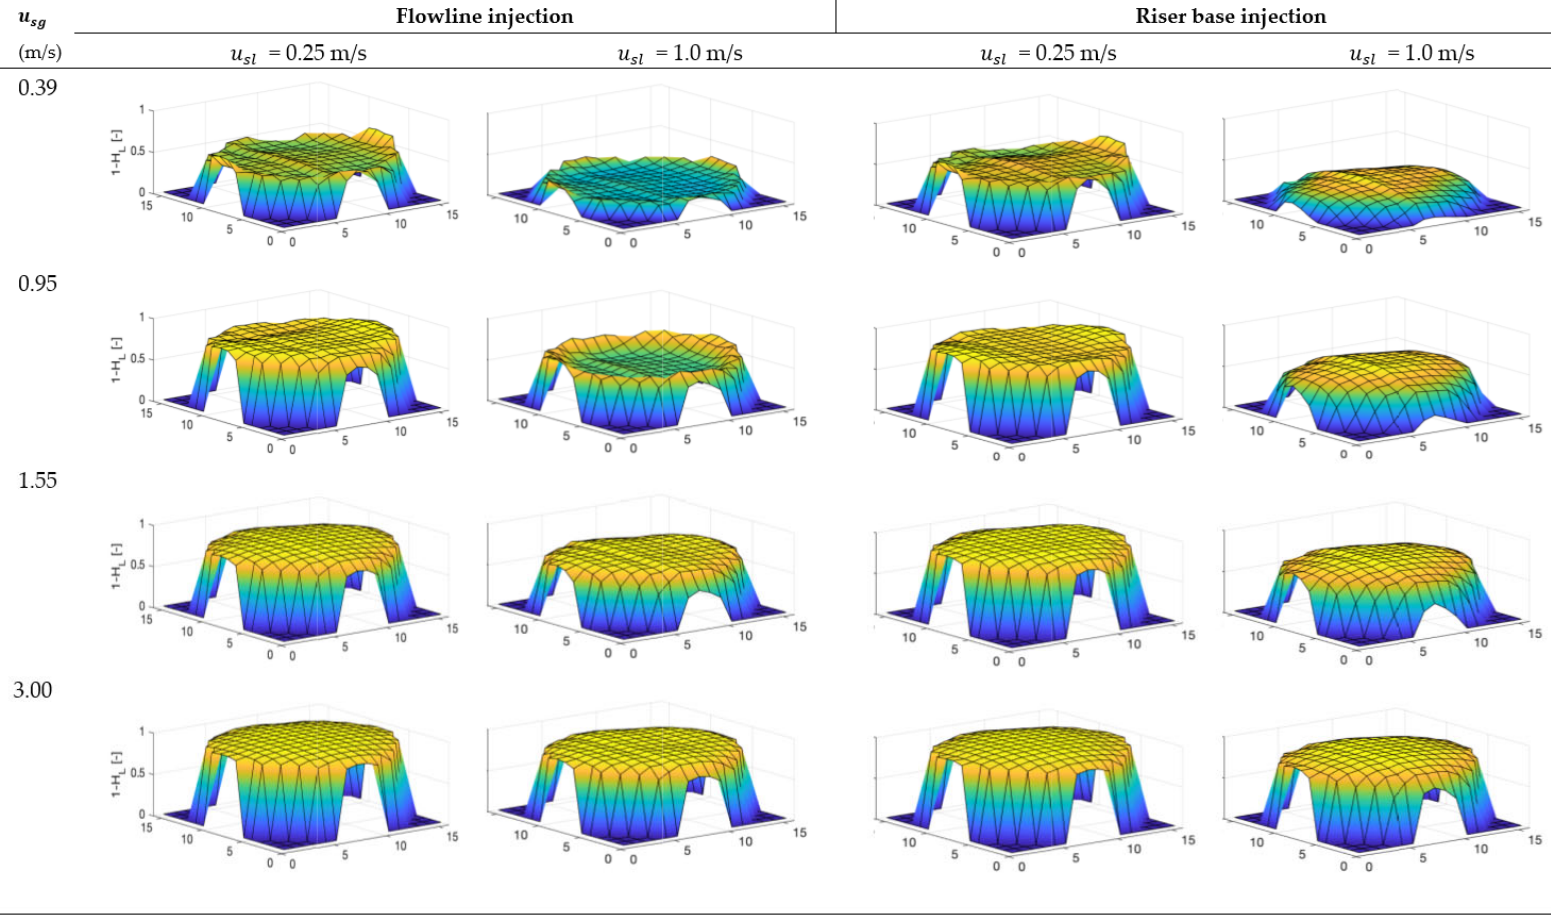
Figure 7. Surface plots of 1 − H L profiles for the riser base and flowline injection methods at u sg = 0.25 and 1.0 m/s for u sl = 0.39–3.00